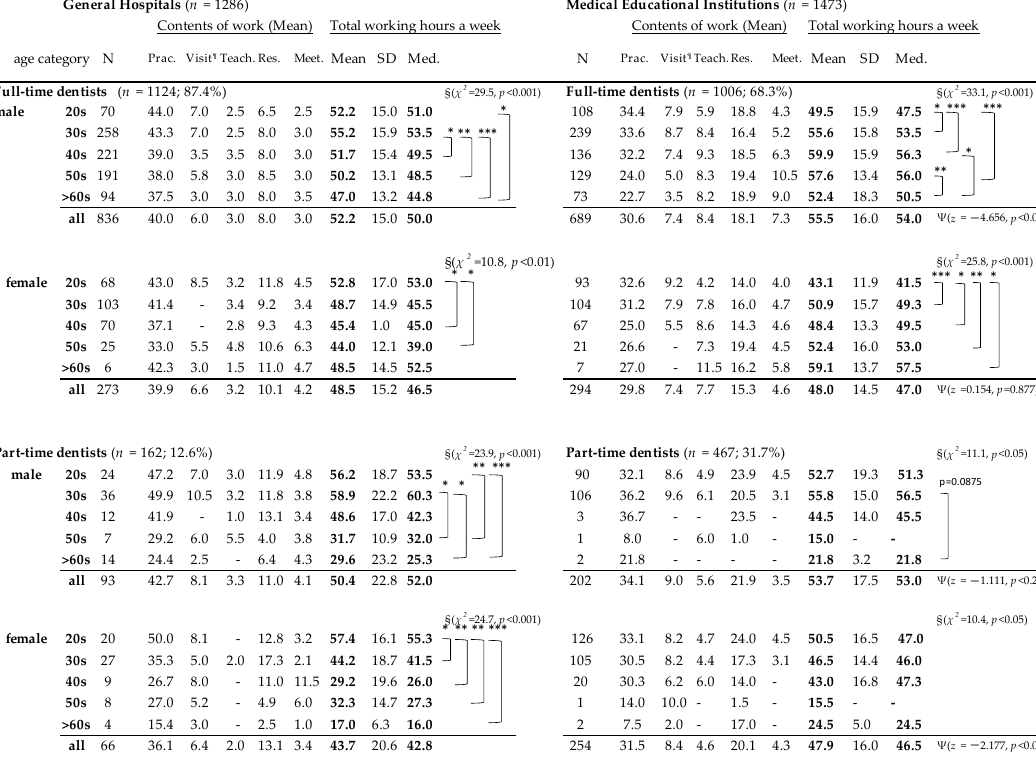
Figure 2. Weekly working hours among hospital dentists by gender, types of work (full time / part time), and age groups according to workplace. * p < 0.05, ** p < 0.01, *** p < 0.001. §KW test: Kruskal–Wallis equality-of-populations rank test was performed and Dunn’s pairwise comparison adjusted by Bonferroni’s method for multiple comparison: the number of hospital dentists who carried out home-visit practice was 332 (199 males and 127 females). Ψ : the di ff erence in total weekly working hours between workplaces was examined by the Mann–Whitney test. Med: median, Prac: in-hospital practice, Visit: home-visit practice, Teach: teaching, Res: research or self-learning, Meet: meeting or